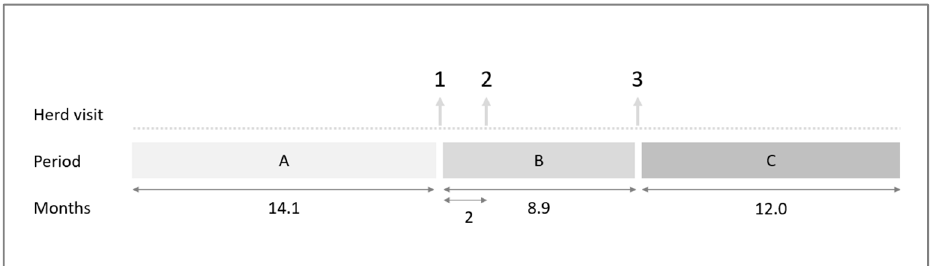
Figure 2. Timeline of the study. Three farm visits were performed, and antimicrobial usage was determined for three different periods (A, B, and C).